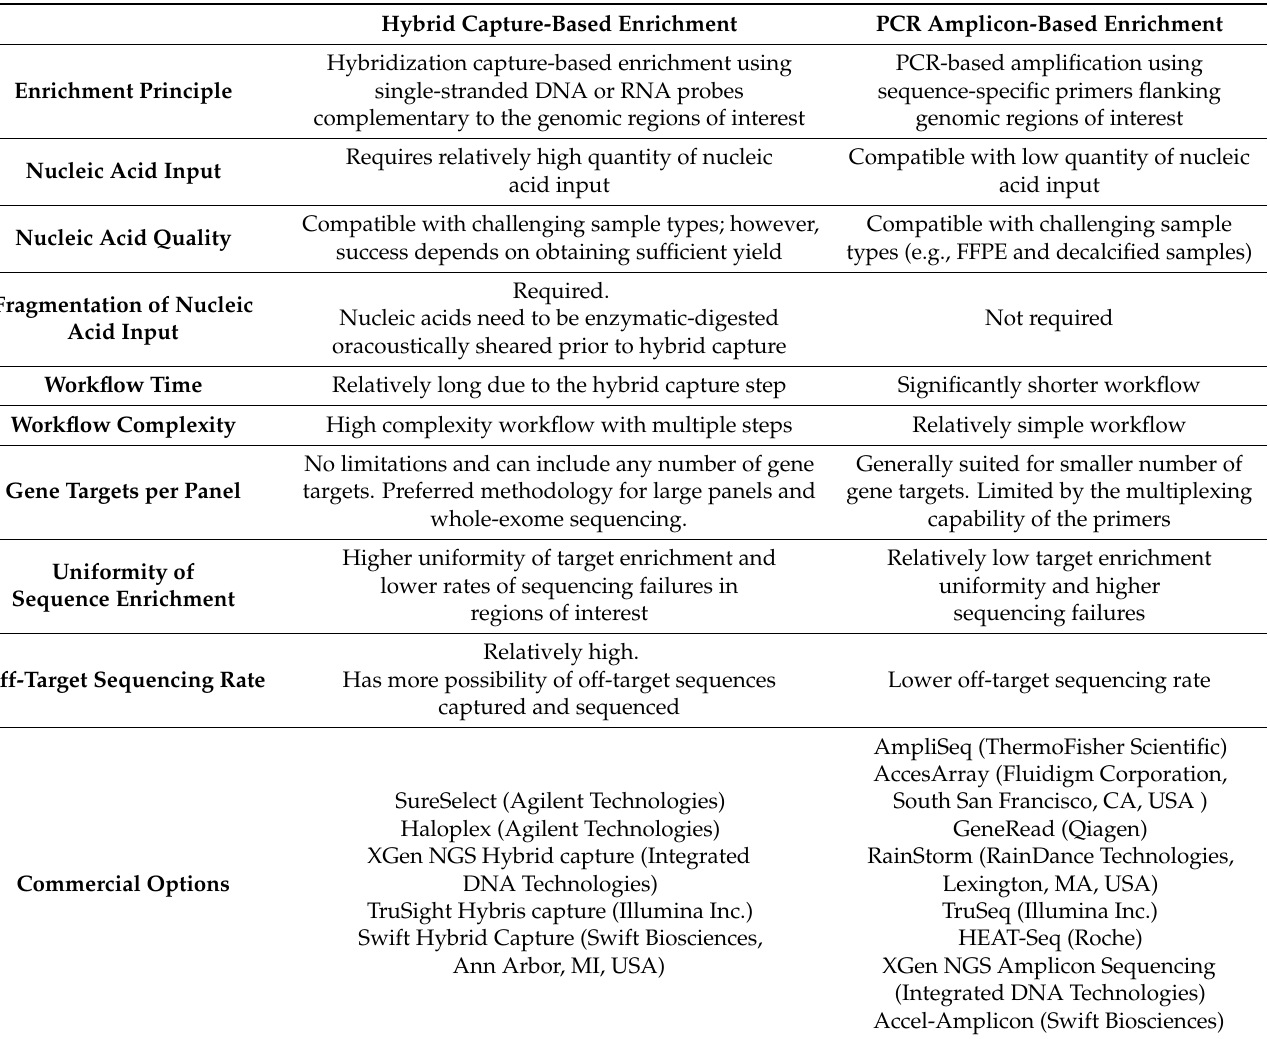
Table 1. Comparison of Amplicon-Based and Hybrid Capture-Based Target Enrichment. A compari- son of the principles, workflow, overall performance, and commercially available options is